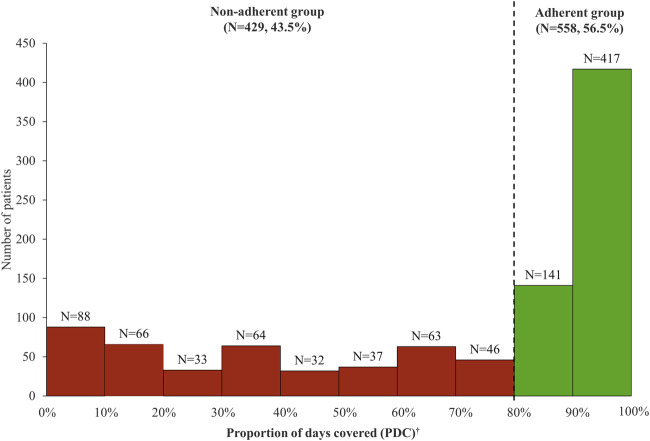
Distribution of proportion of days covered (PDC) among patients initiating tuberculosis drug. *Mean PDC was 68.87% (standard deviation, 33.37%). †Patients with PDC ≥80% were classified as adherent group and patients with PDC <80% were classified as non-adherent group.